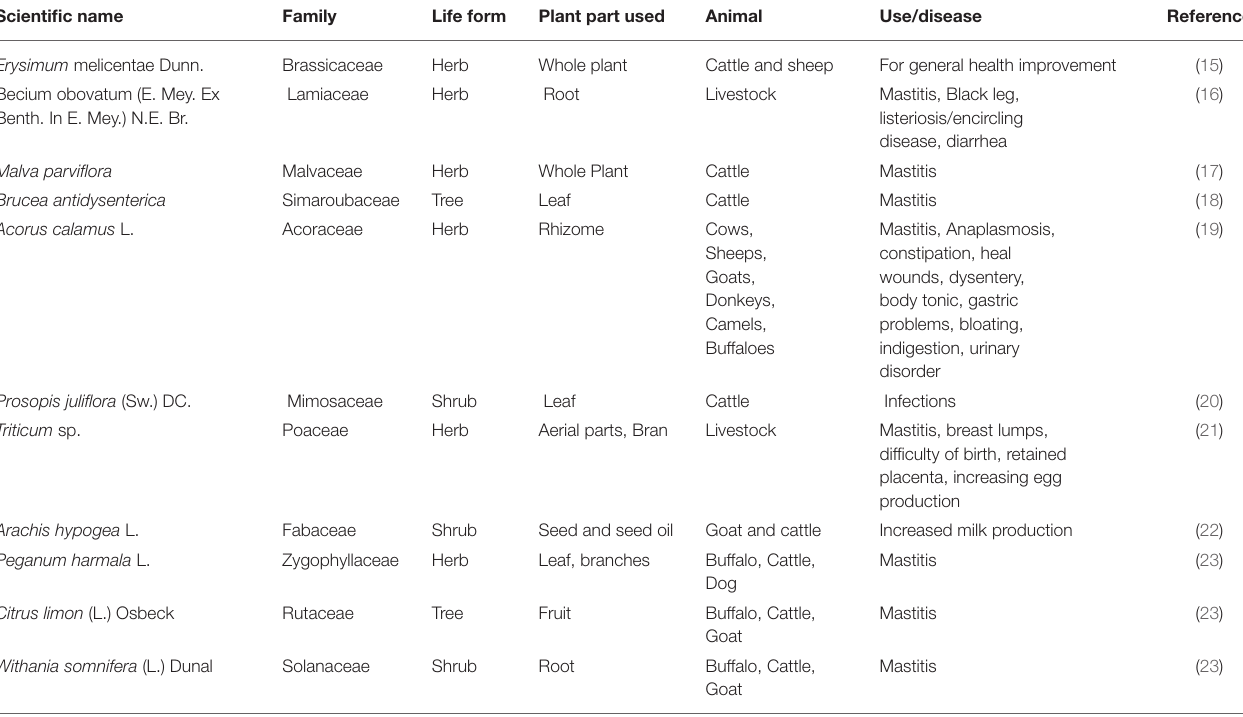
TABLE 2 | Ethno-veterinary medicinal plants used in the dairy and livestock